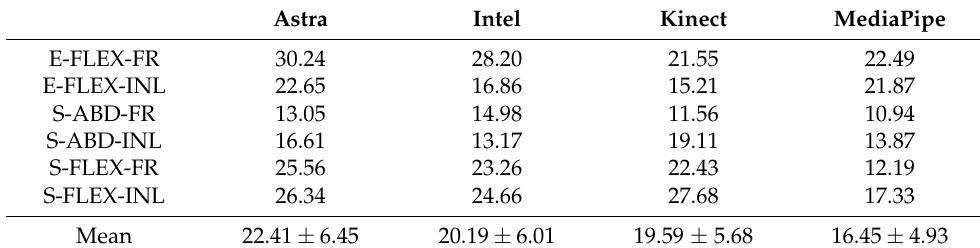
Table 11. RMS values of absolute error and mean for upper limbs.